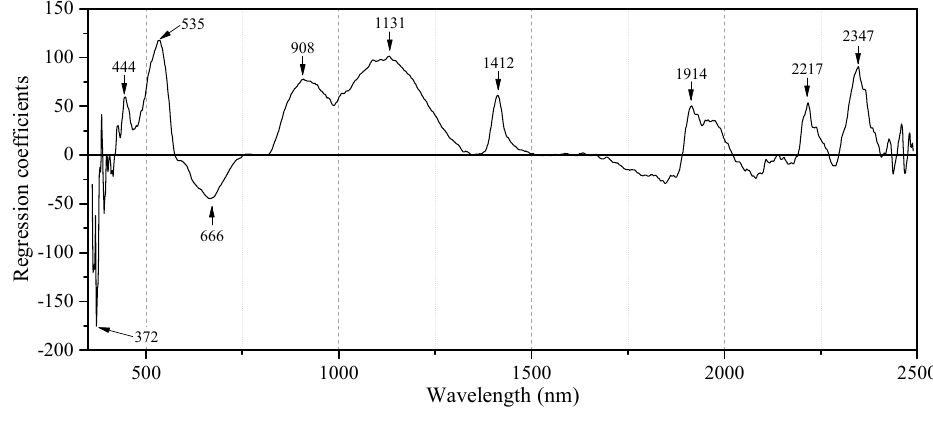
Figure 11. Regression coefficients of topsoil model. Table 5. Correlation coefficients of latent variables and soil properties.